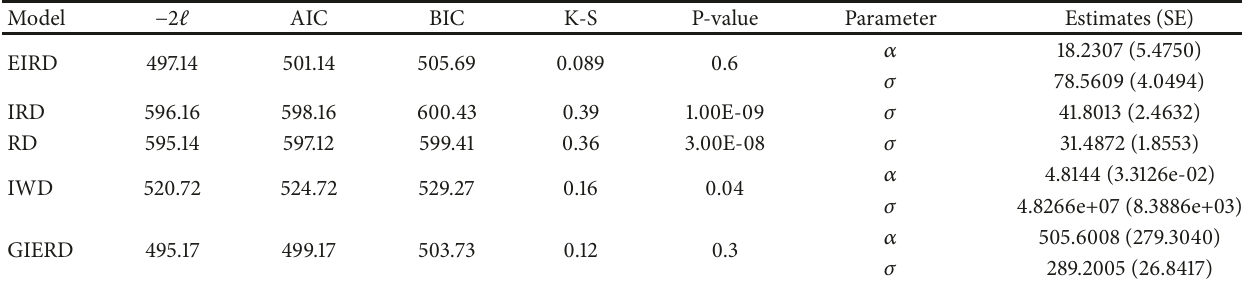
Table 7: Statistics of the goodness-of-fit, MLE, and standard errors (SE) for Bcs.